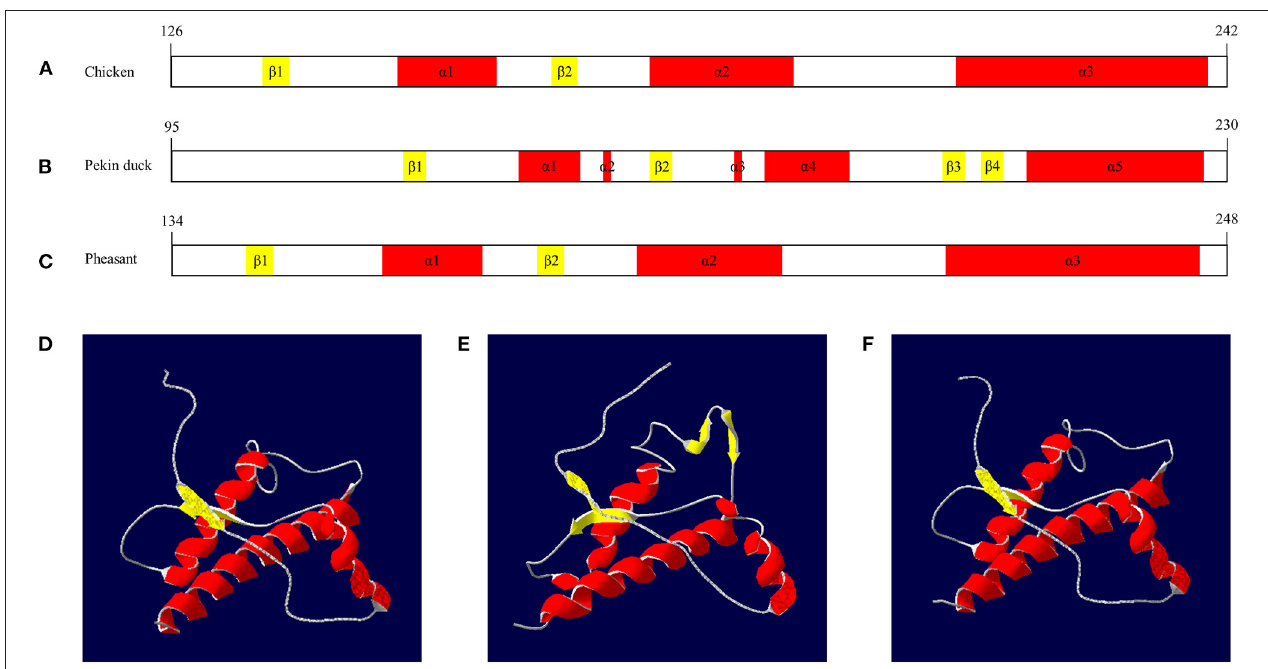
FIGURE 4 | The secondary and tertiary structures of avian PrPs. (A) The secondary structure of the chicken PrP. (B) The secondary structure of the Pekin duck PrP. (C) The secondary structure of the pheasant PrP. (D) The tertiary structure of the chicken PrP. (E) The tertiary structure of the Pekin duck PrP. (F) The tertiary structure of the pheasant PrP. The colors indicate α -helices (red), β -sheets (yellow) and coils (white). The secondary and tertiary structures of avian PrPs were analyzed by SWISS-MODEL and Swiss PDB